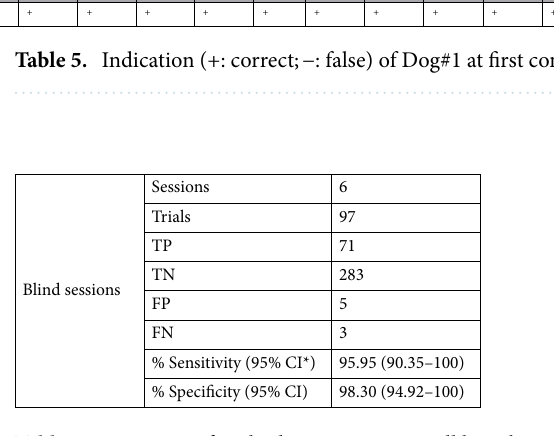
Table 6. Detection of multiple osteosarcoma cell lines by Dog#1. *Confidence interval calculated with the values obtained in the different sessions.